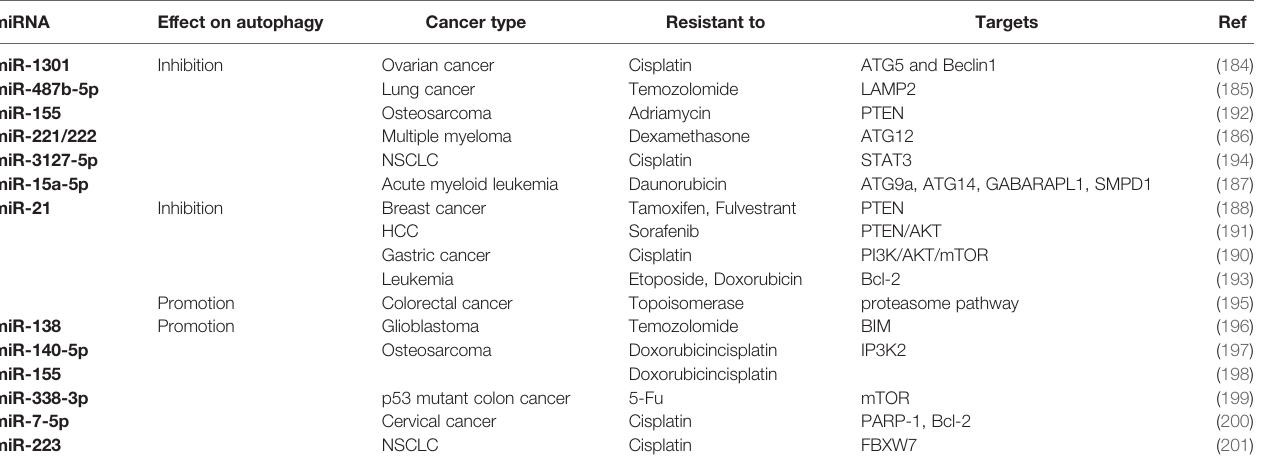
TABLE 2 | Inhibition of miRNA combat chemoresistance by regulating autophagy.